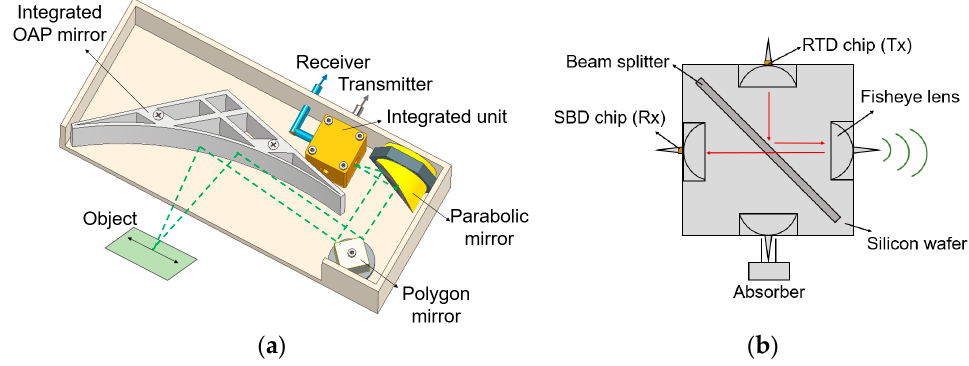
Figure 14. ( a ) Schematic diagram of the miniaturized THz imaging system. ( b ) Schematic diagram of integrated unit structure. (RTD: resonant tunneling diode, SBD: Schottky barrier diode.)